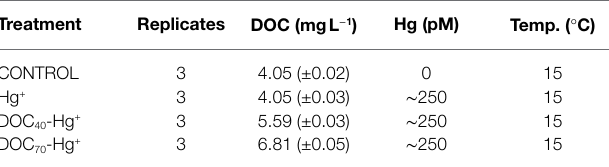
TABLE 1 | Experimental layout showing concentrations of dissolved organic carbon (DOC) and total mercury (Hg) in the different treatments achieved after the corresponding